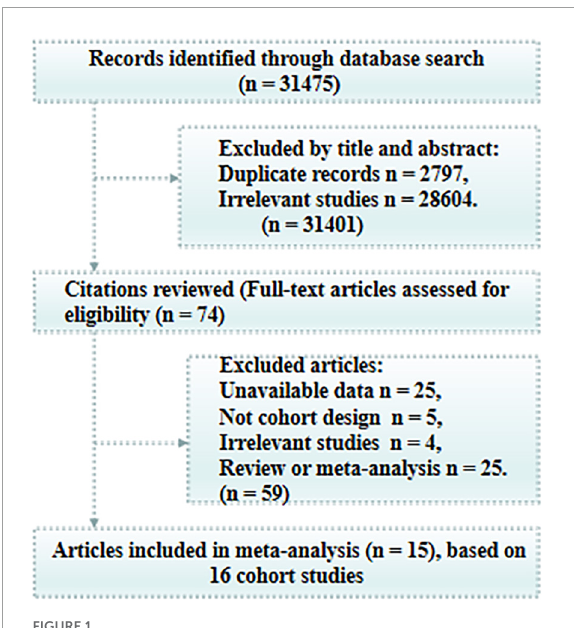
FIGURE1 Process of literature search and study